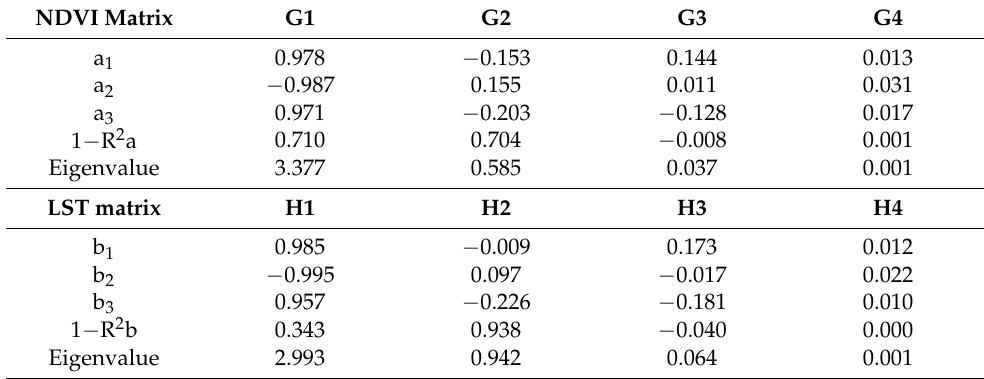
Table 2. Weights for principal components G1–G4 and H1–H4 and eigenvalues (sample plot No. 1).